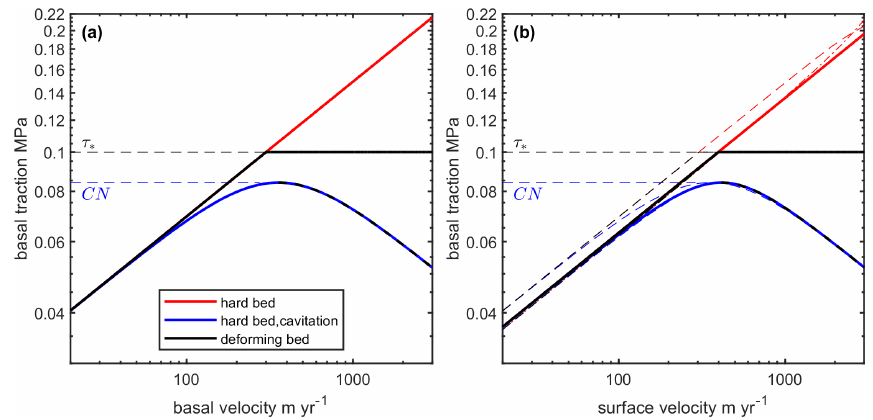
Figure 3. (a) Traction models that relate basal motion to basal traction for hard beds with and without cavitation and for deforming beds. CN indicates Iken’s bound, and τ ∗ is the critical shear stress for deforming till (these parameters are set to fit the curves within the plotting space). (b) The same relationships are shown with added deformation motion calculated with T = 0 ◦ and H = 2500m. The bounds show deformation motion where parameters in the deformation calculation change with velocity. For the higher bound, H is held constant at 2500m while T increases from − 25 ◦ to 0 ◦ through the velocity range. For the lower bound, T is held constant at 0 ◦ and H decreases from 3000 to 200m through the velocity